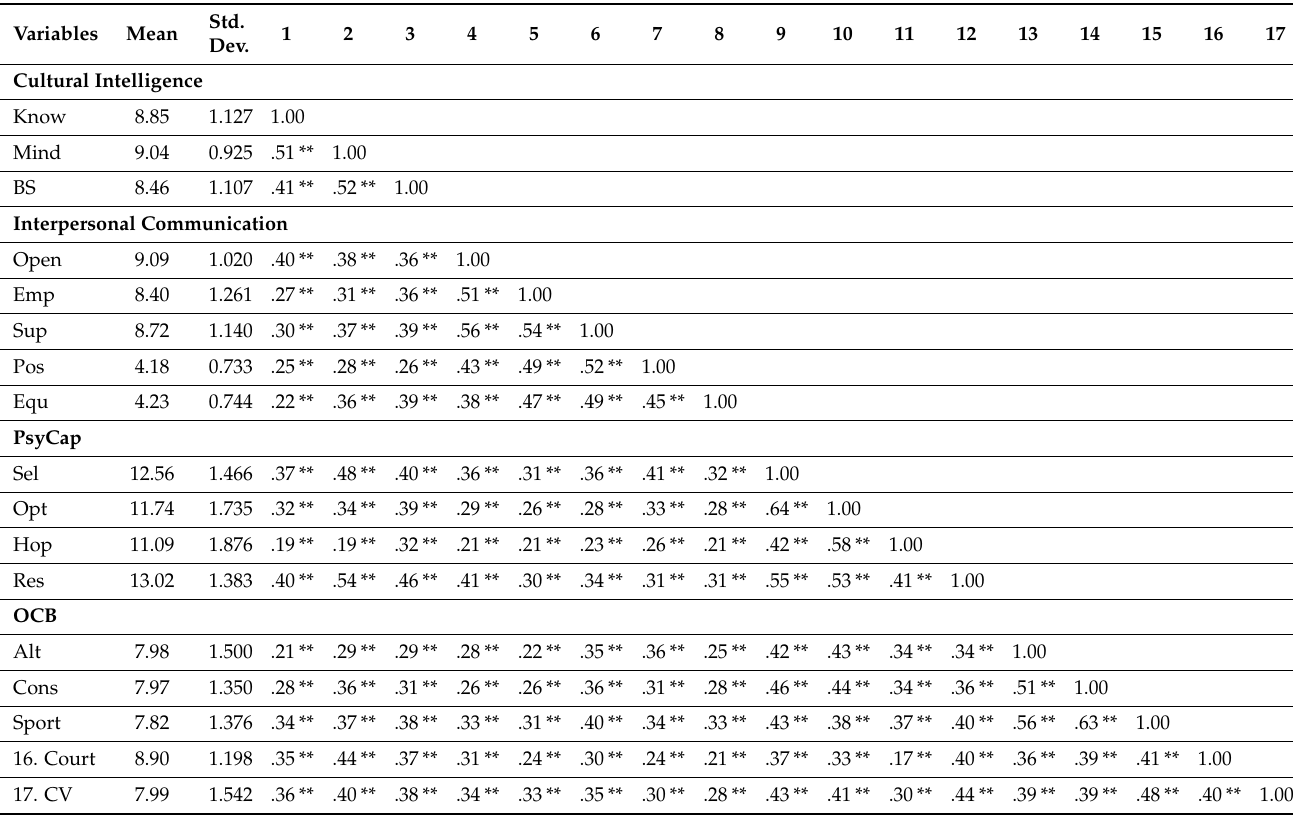
Table 2. Descriptive statistics and correlation